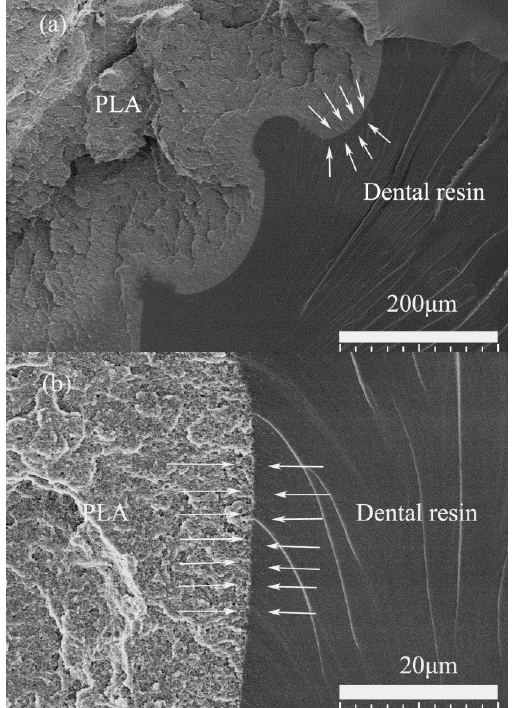
Figure 10. SEM images of specimen’s fractured surface of UDMA/TEGDMA resin and printed PLA braiding structure, with arrows pointing out the edge of these two materials: ( a ) scale of SEM image is 200 µm; ( b ) scale of SEM image is 20 µm.